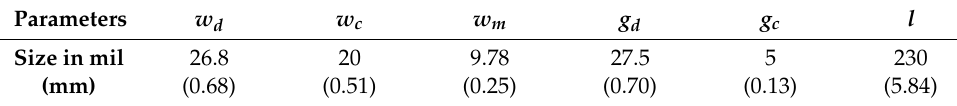
Figure 9. Top and bottom views of the proposed DL-to-CPS Transition. Table 2. Design parameters of the DL-to-CPS transition.